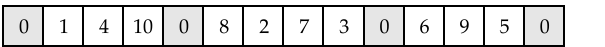
Figure 1. An example of a solution representation for a CARP instance with 10 required tasks, where 0 is the id of the dummy task. In this example, there are 3 routes. The first route services the tasks with id s 1, 4 and 10. The second services the tasks with id s 8, 2, 7 and 3. The third services the tasks with id s 6, 9 and